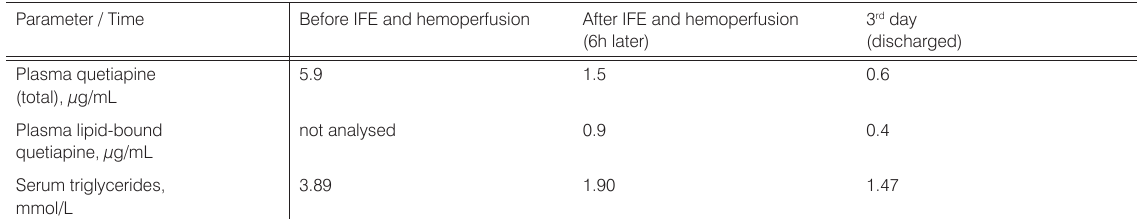
Table 1. Quetiapine plasma concentration (total and lipid-bound) and serum triglycerides level. Parameter / Time Before IFE and